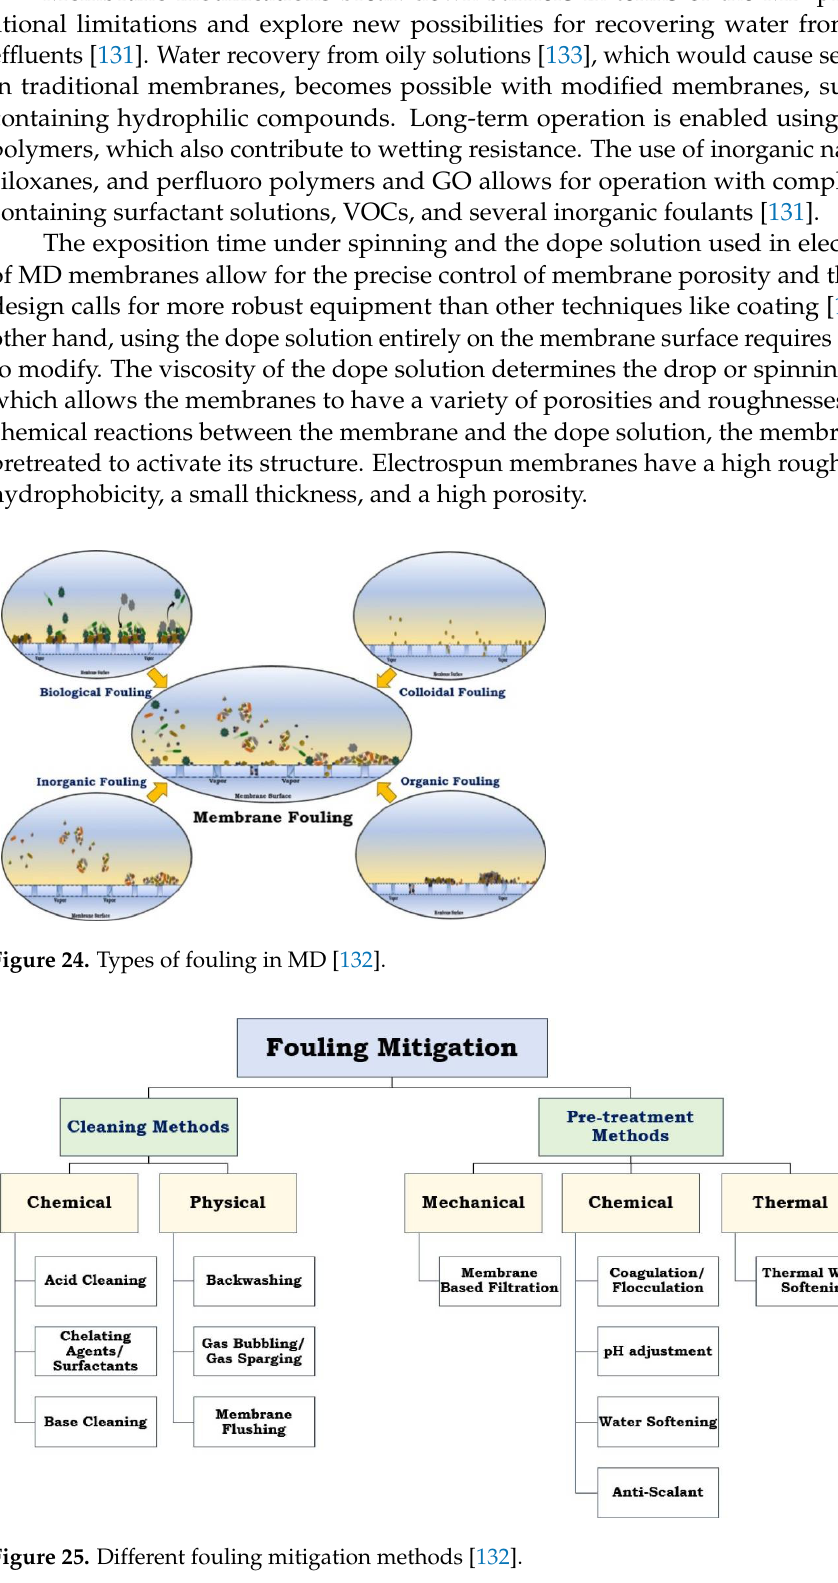
Table 1. Desired values for the properties of the membranes used in the MD process. Adapted from [129–131].